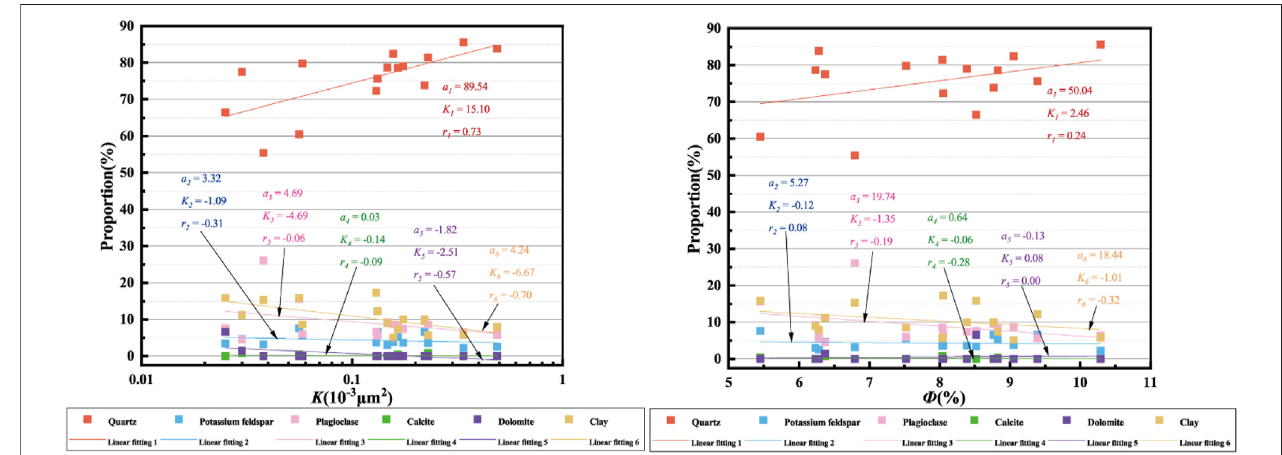
FIGURE 10 | Correlation relationships between permeability (left) , porosity, and mineral